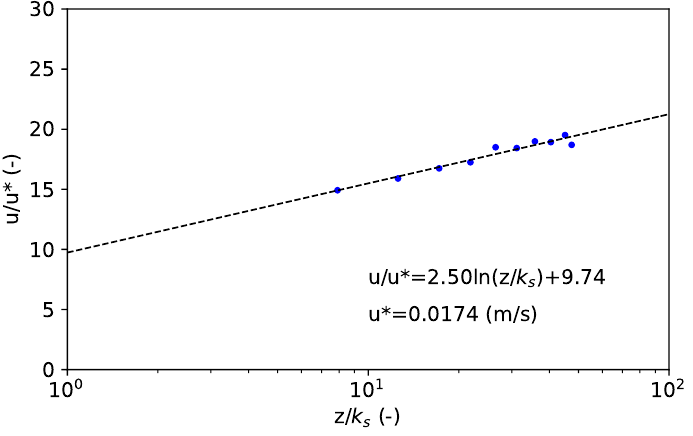
Figure 6. Longitudinal velocity profile measured in the flume mid-plane and at the distance 0.50 m upstream the Pier 11’s front. Experimental data ( ◦ ) and theoretical approximation line (dashed